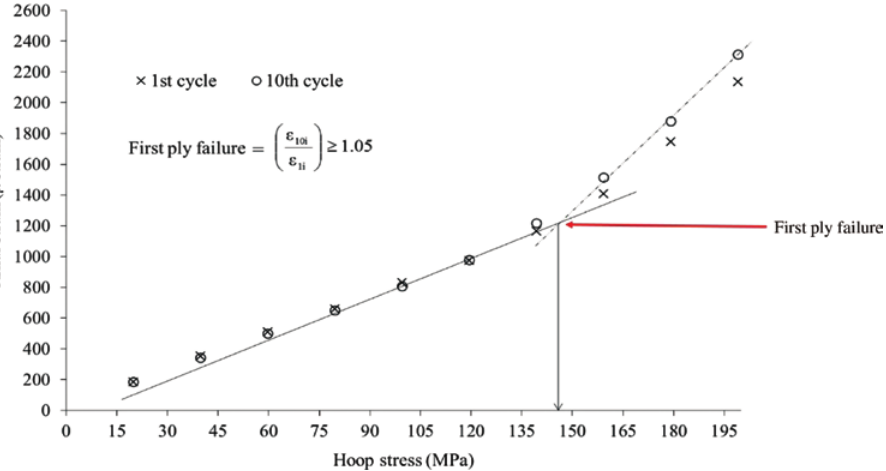
Figure 11: First ply failure estimation based on hoop stress to axial